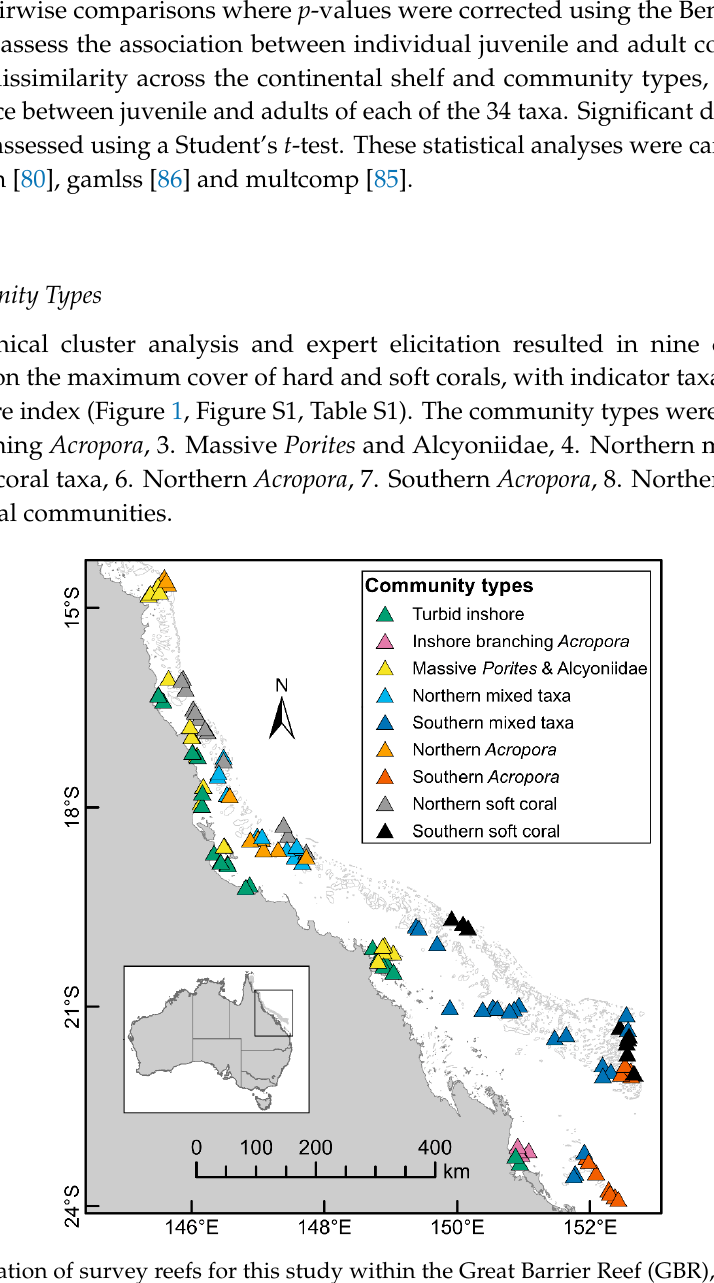
Figure 1. Location of survey reefs for this study within the Great Barrier Reef (GBR), reefs are color coded by community types computed using hierarchical clustering and expert elicitation.